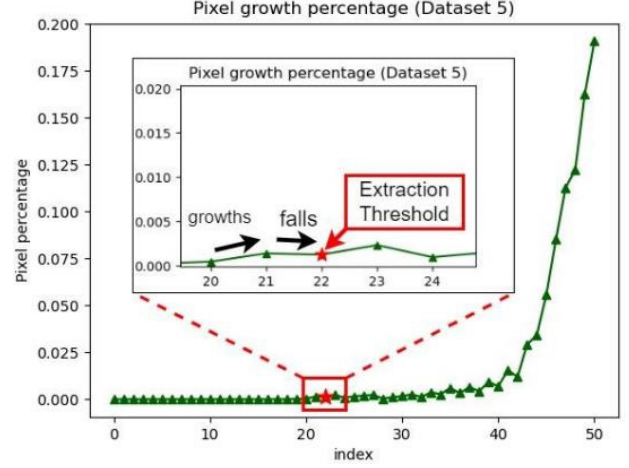
Figure 36. Graph of pixel growth ratio.